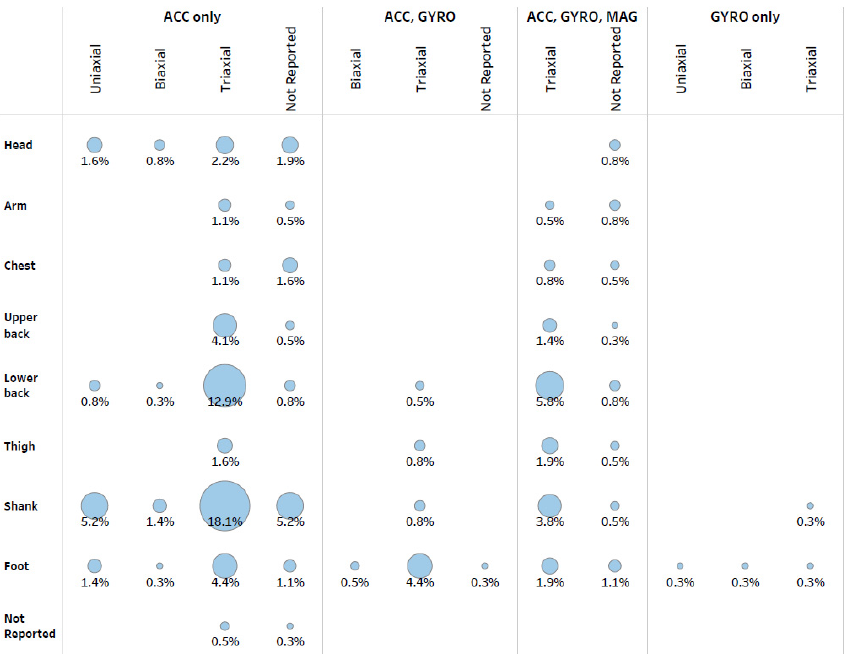
Figure 4. The percent of all combinations of devices and locations of devices on the body (365 combinations across 231 studies) by body location and sensor/axis composition. The circles are sized relative to percentage to provide visual comparisons for the frequency of device and location combinations. ACC = accelerometer, GYRO = gyroscope, and MAG = magnetometer. Some studies used multiple devices, bringing the total number of devices to 251.